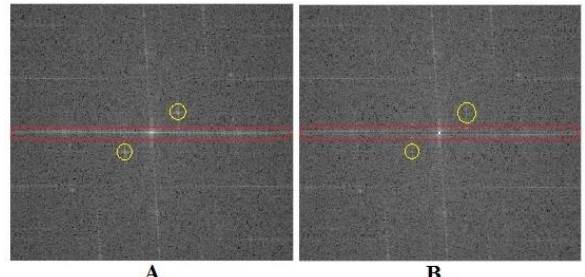
Figure 10. A) The power spectrum of image band 1 before the striping noise removal, B) power spectrum of the image after noise removal. The red box indicates the position of the vertical stripes component and yellow box indicates the position of the components of the diagonal stripes before and after the image modification.